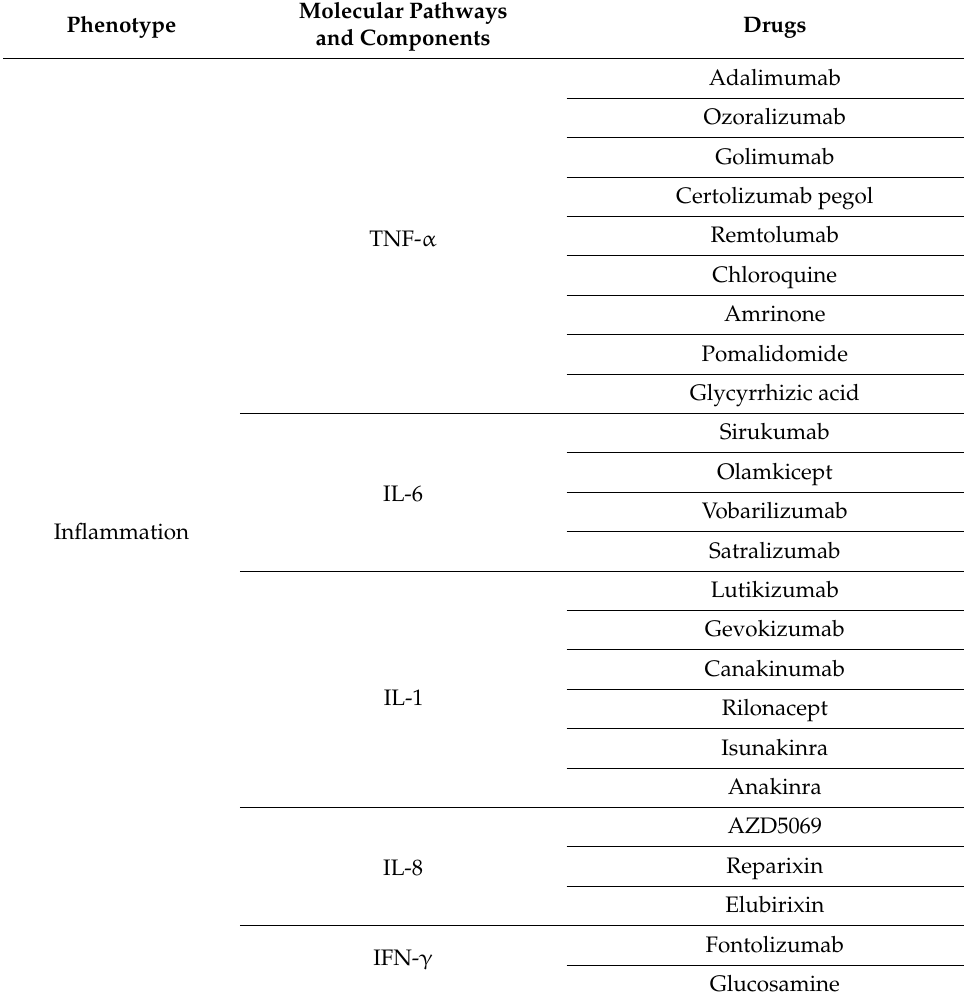
Table 2. Molecular pathways and respective drugs involved in